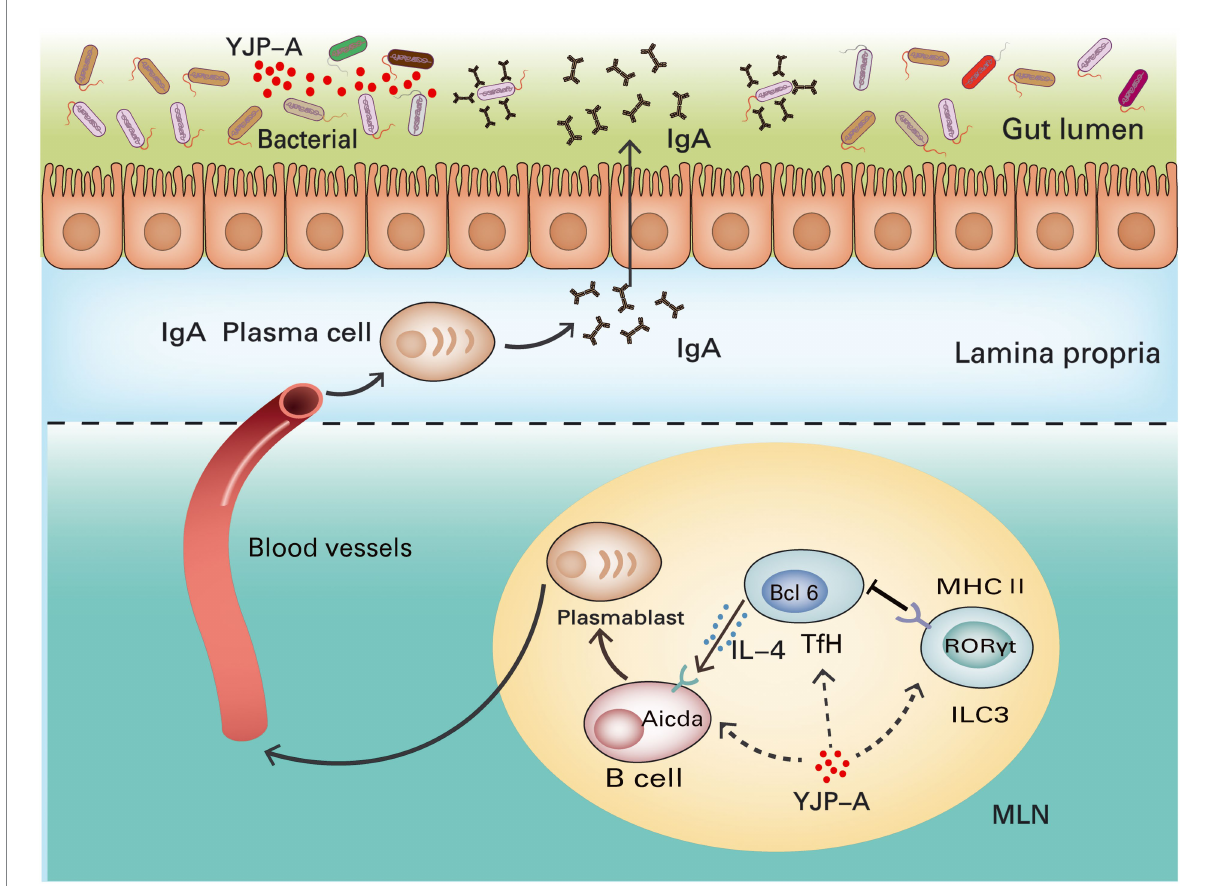
FIGURE 11 Mechanisms of YJP-A ameliorating DSS-induced ulcerative colitis by ILC3s-TD IgA-colonic mucosal flora axis. The ILC3s and MHC II expression were suppressed in MLNs of DSS-induced UC mice, resulting in the proliferation of Tfh cells and inducing class switching of IgA + B cells by increasing IL-4 levels and hypersecretion of TD IgA in turn causing the disorder of colonic mucosal flora. YJP-A showed protective effects on UC mice by regulating ILC3s-TD IgA-colonic mucosal flora